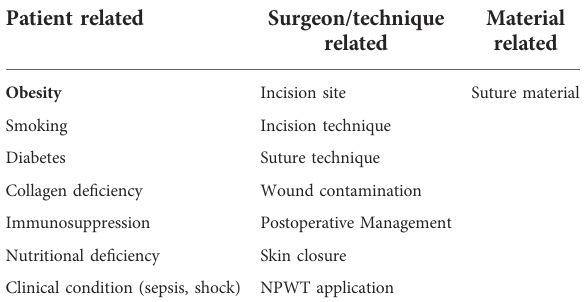
TABLE 1 Factors in fl uencing wound healing after abdominal wall closure (1, 2, 7, 10 – 15).